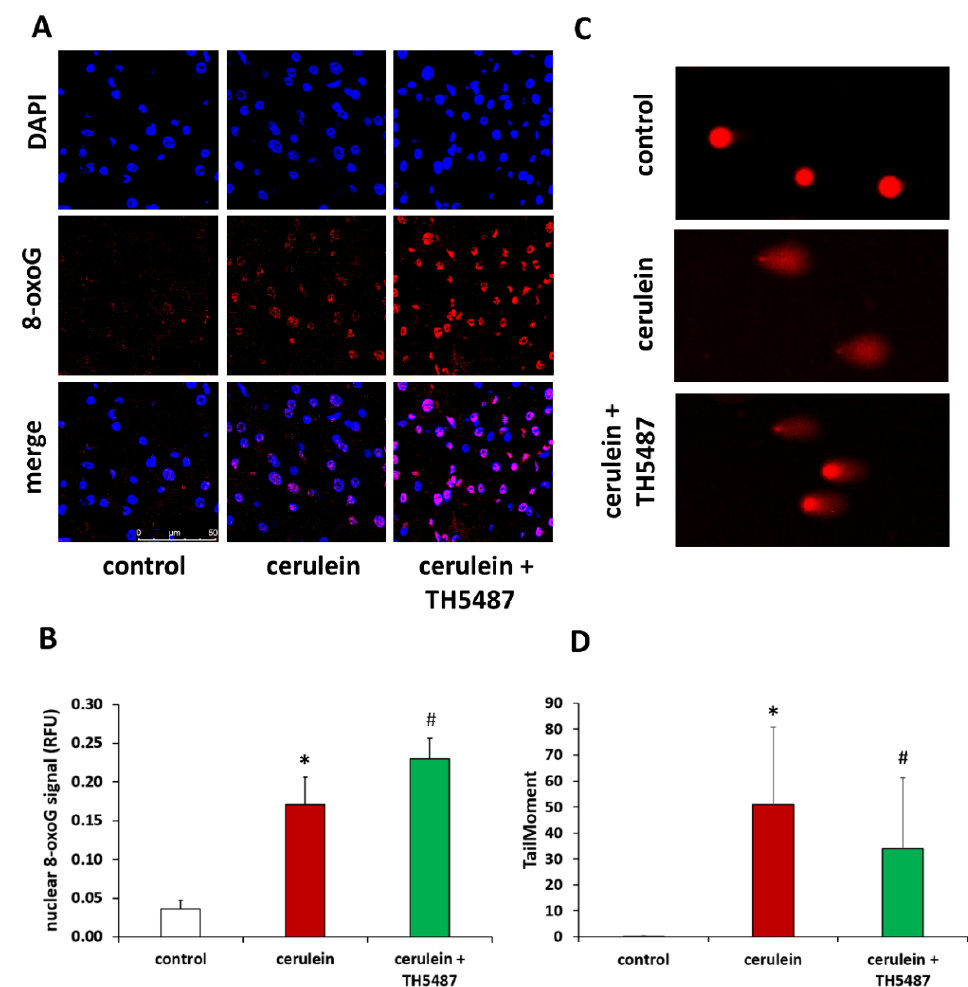
Figure 3. TH5478 increases 8 ‐ oxoG content but decreases DNA strand breakage. ( A ) Immunofluorescence staining of pancreas tissue sections for 8 ‐ oxoG (red) as the index of oxidative DNA damage. Nuclei were counterstained with DAPI (blue). Magnification was 400×. The scale bar is 50 μ m. ( B ) The intensity of 8 ‐ oxoG increased significantly in the TH5487 ‐ treated group compared to the cerulein group. ( C ) The level of DNA strand breakage in primary acinar cells was detected by alkaline comet assay. Prior to the 100 nM cerulein treatment, cells were preincubated with 5 μ M TH5487 for 1 h. ( D ) Cerulein treatment induced DNA breakage and OGG1 inhibition reduced the amount of DNA breakage. Values are presented as mean ± SD. * p < 0.05 vs. control group, # p < 0.05 vs. cerulein group*.